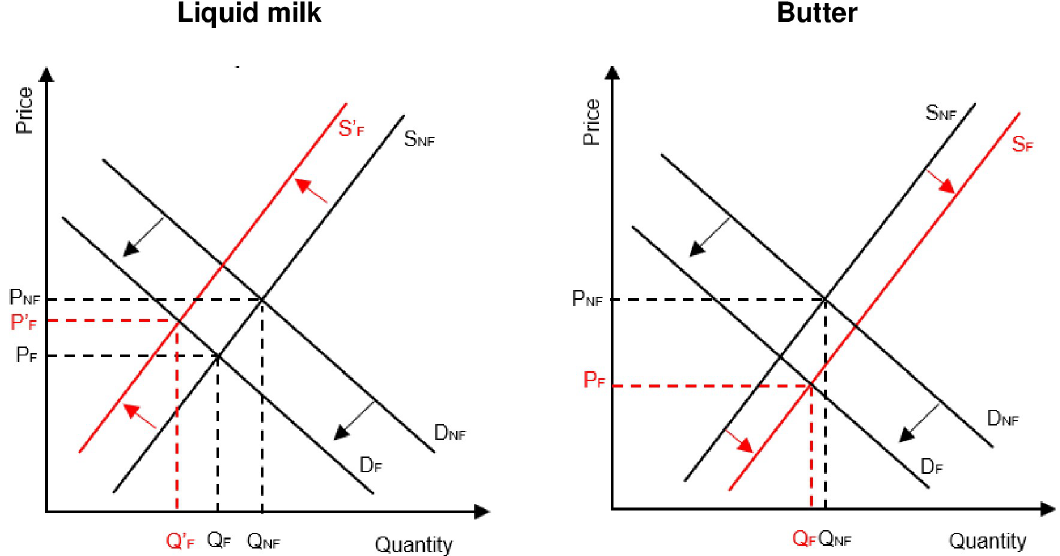
Fig 1. Demand and supply framework illustrating the impact of fasting on the liquid milk and butter markets. (1) Lent; (2) Easter; (3) Easter-May; (4) Jun-Advent; (5) Advent; (6) Christmas; (7) Christmas-current.